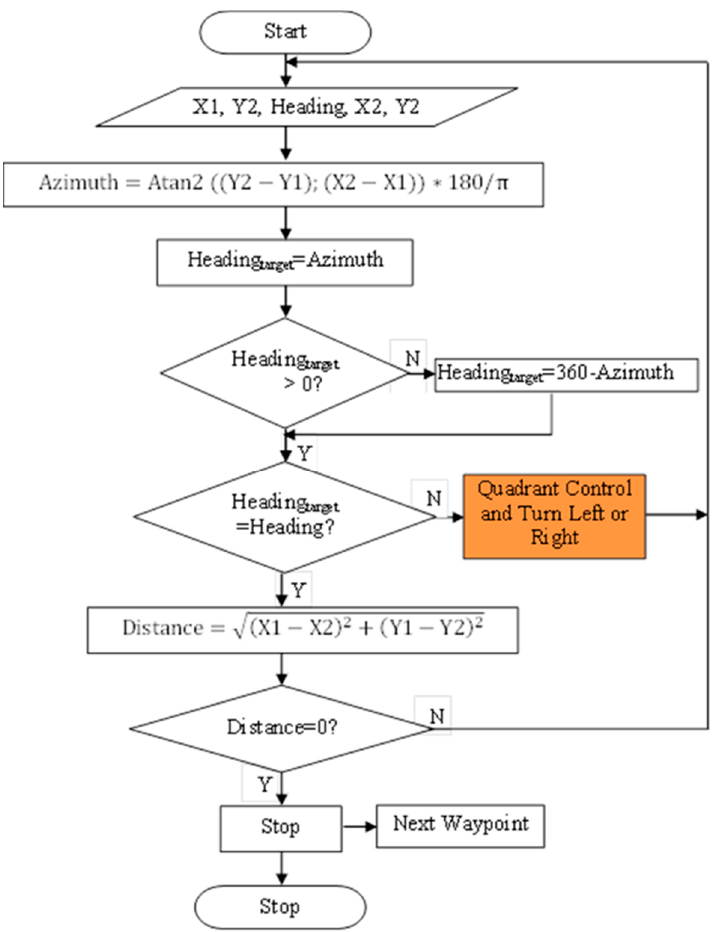
Figure 3. The flowchart for autonomous drive of the mobile robot.